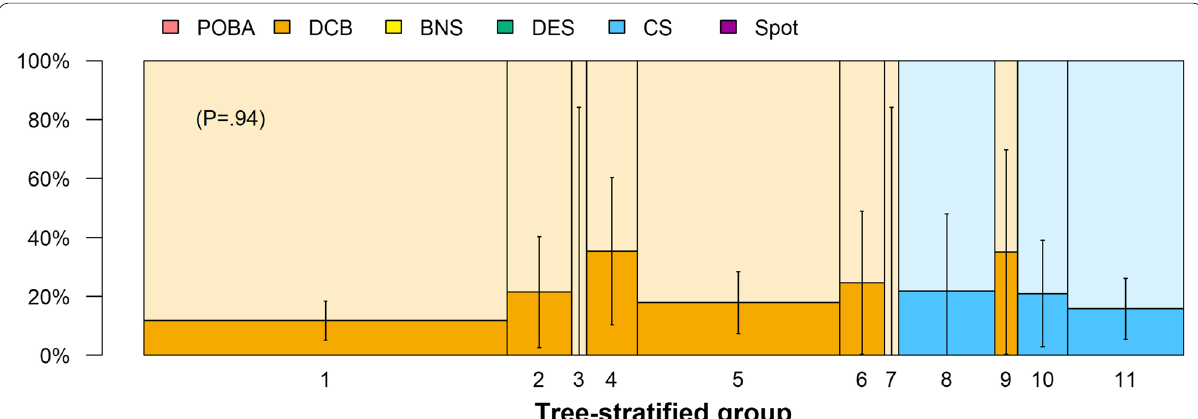
Fig. 6 The restenosis rate of reference strategy in each category. The most popular strategy set the reference in DCB, DES, and CS. BNS: bare nitinol stent, CS: covered stent, DCB: drug-coated balloon, DES: drug-eluting stent, POBA: plain old balloon